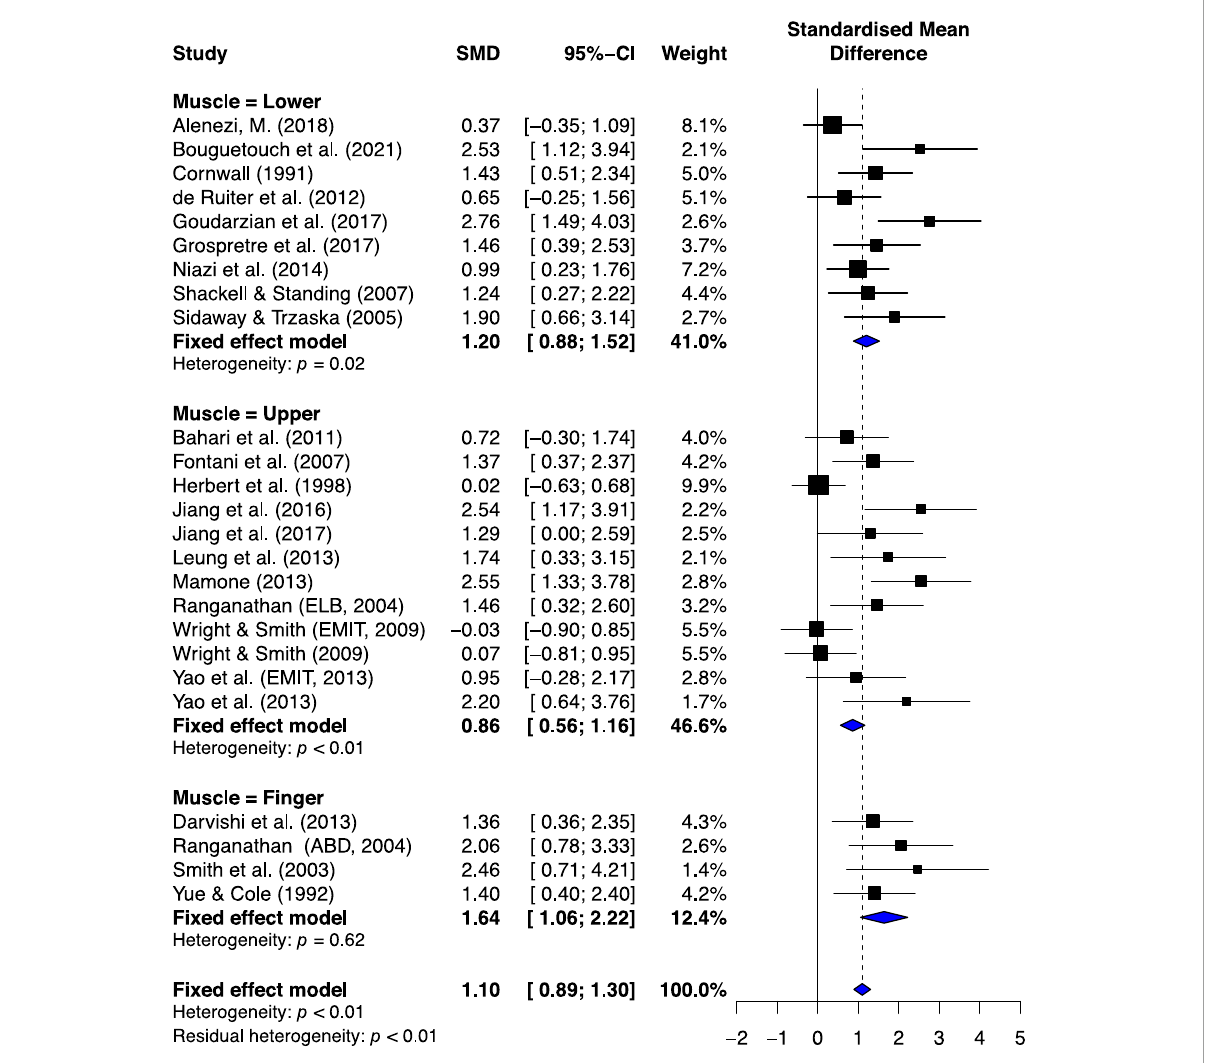
FIGURE5 Muscle subgroup’s effects on maximal muscle strength: Mental imagery training (MIT) vs. control